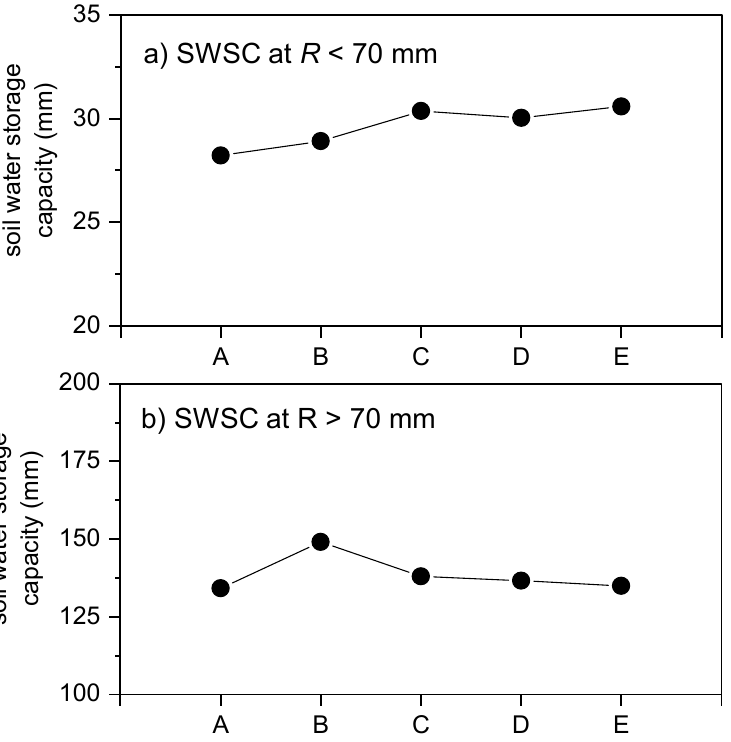
Figure 8. Decadal changes in soil water storage capacity at ( a ) weaker ( R < 70 mm) and ( b ) stronger ( R > 70 mm) continuous-rainfall events.